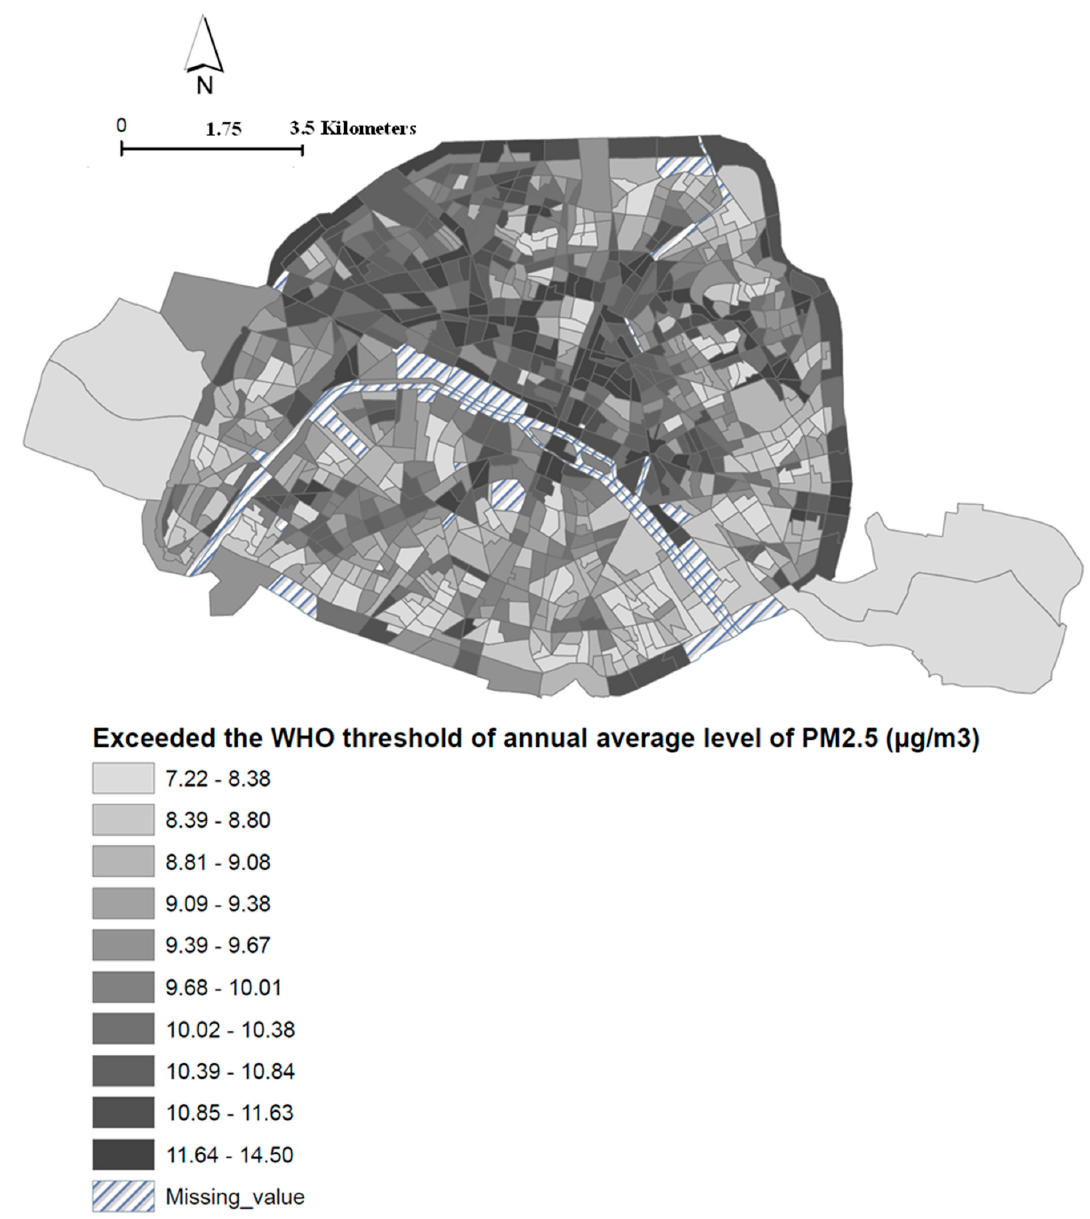
Figure A3. Spatial distribution of the exceeded the WHO threshold of annual average level of PM 2.5 from 2000–2009 (the difference between level of PM 2.5 exposure in each census block and WHO guidelines (10 μ g/m 3 )).